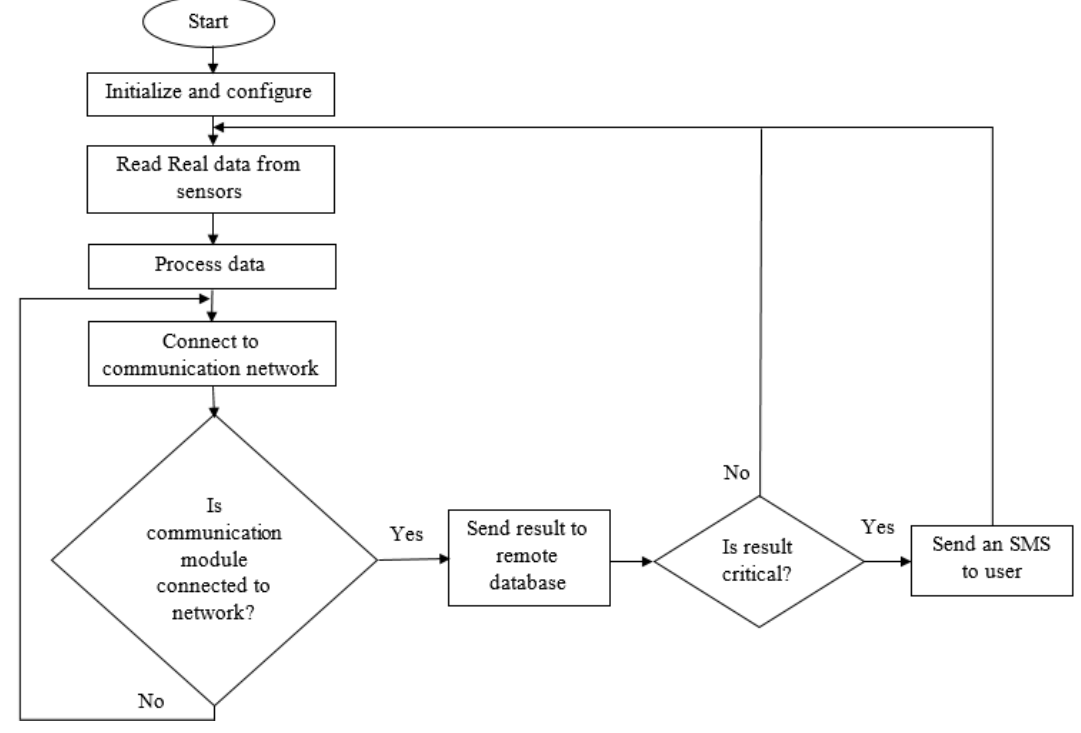
Figure 11. Program running in Microcontroller of the proposed